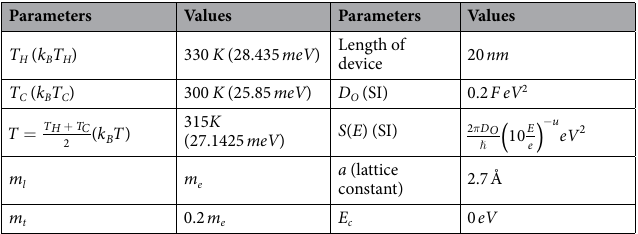
1 , N x N N x y for 2